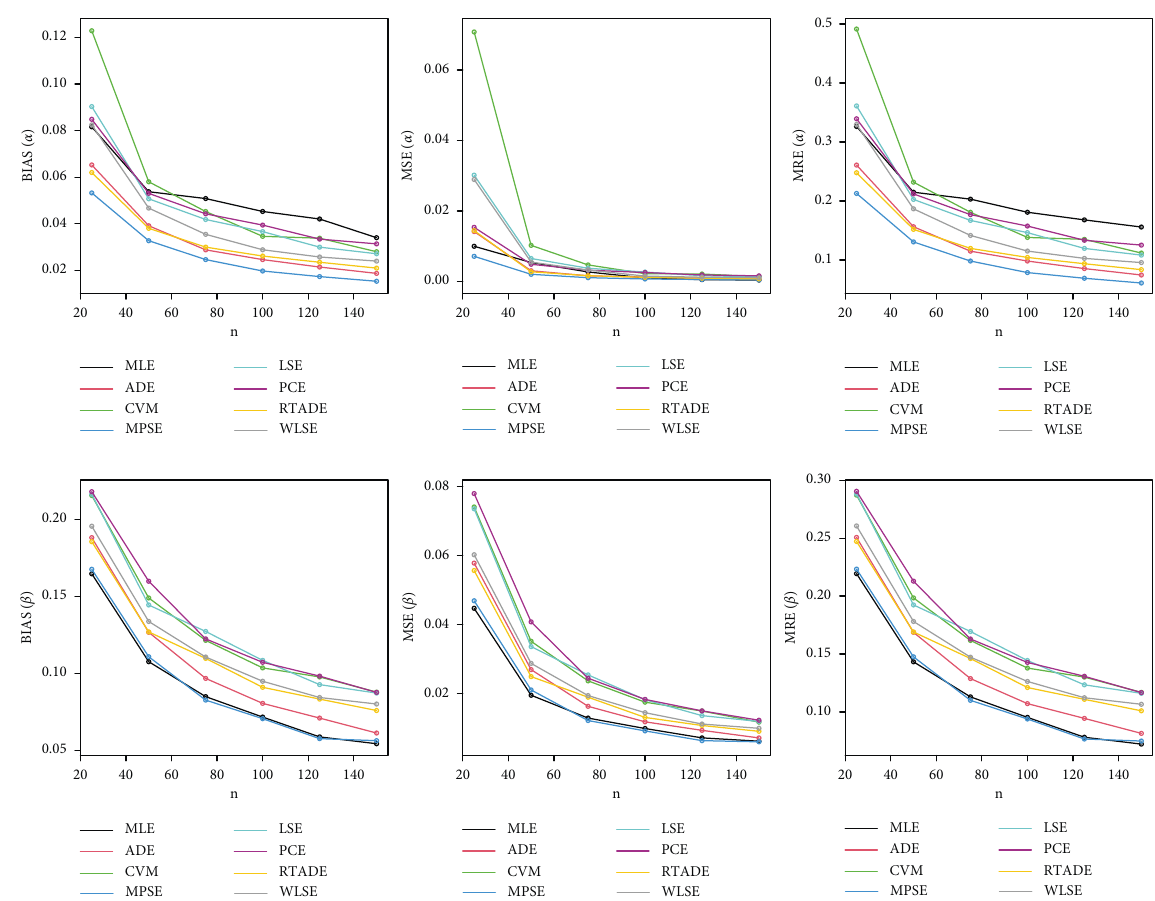
Figure 3: Graphical representation of BIAS, MSE, and MRE values in Table